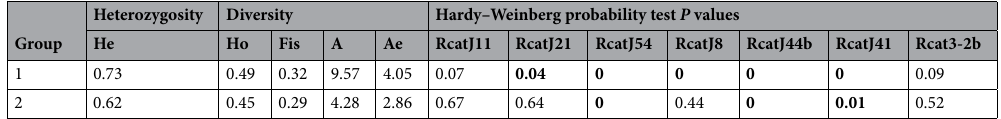
Table 2. Characteristics of bullfrog populations in Brazil. He Expected heterozygosity, Ho Observed heterozygosity, Fis Size corrected Wright’s inbreeding coefficient, A Number of alleles per locus, Ae Effective number of alleles per locus. P values that are still out of Hardy–Weinberg equilibrium after False Discovery Rate corrections appear in bold.